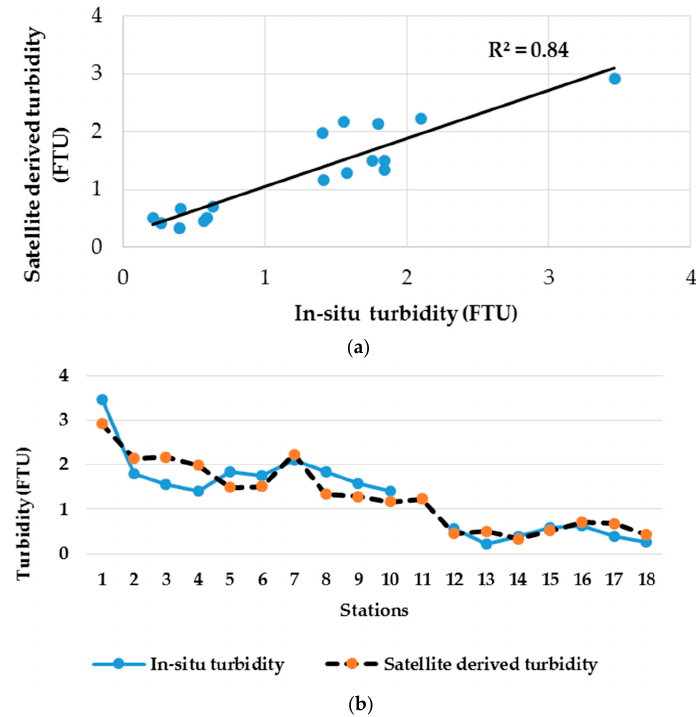
Figure 4. Scatter plots ( a ) and line graphs ( b ) comparing between satellite retrieved and observed turbidities at 18 stations shown in Figure 1 (observed turbidity missing at Station 11). Table 6. Comparison of observed and retrieved turbidities with statistical analyses for squared residual, root mean square (RMSE) and scatter index (SI) from Station 1 to Station 18 except Station 11 in Figure 1.